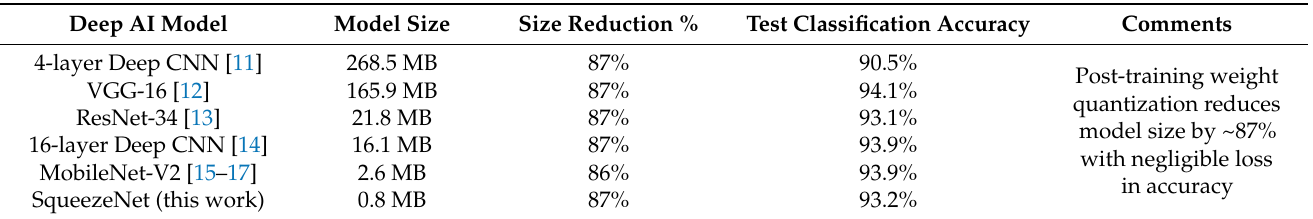
Table 6. Size and accuracy comparison of potential deep AI models with post-training weight quantization.